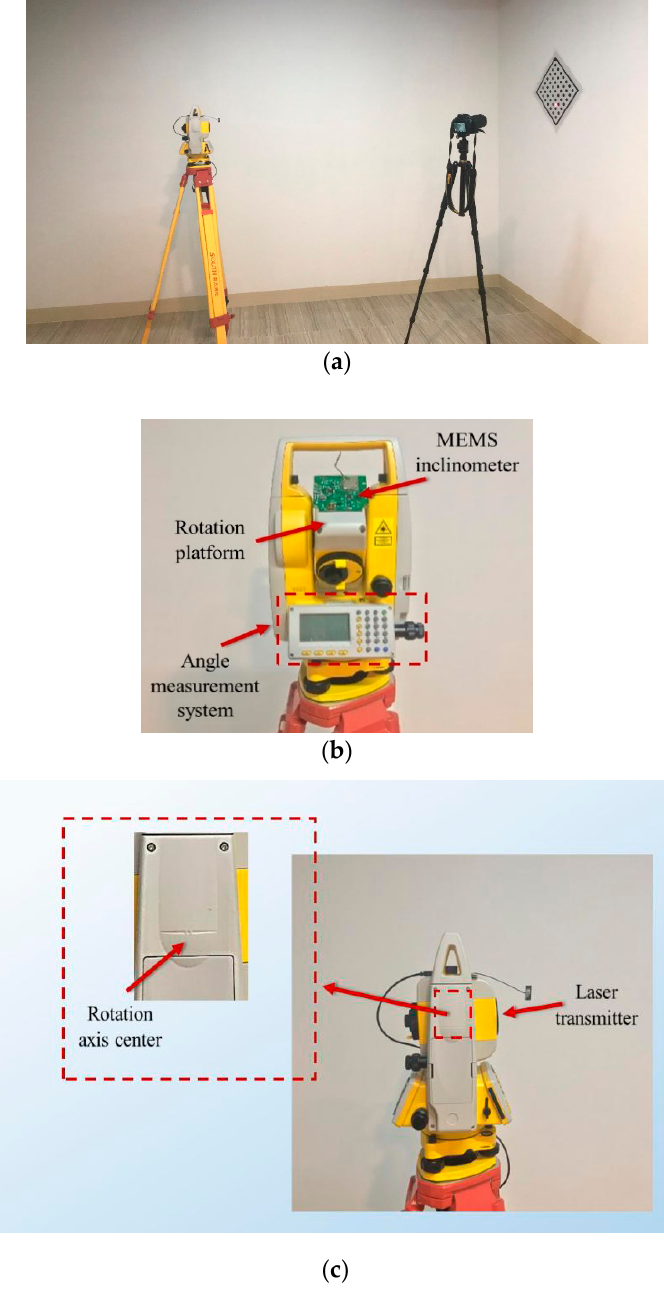
Figure 9. Setups for the validation experiments. ( a ) The setup for the calibration experiment; ( b ) the setup of the devices on the rotation platform; ( c ) the rotation axis center of the rotation platform.